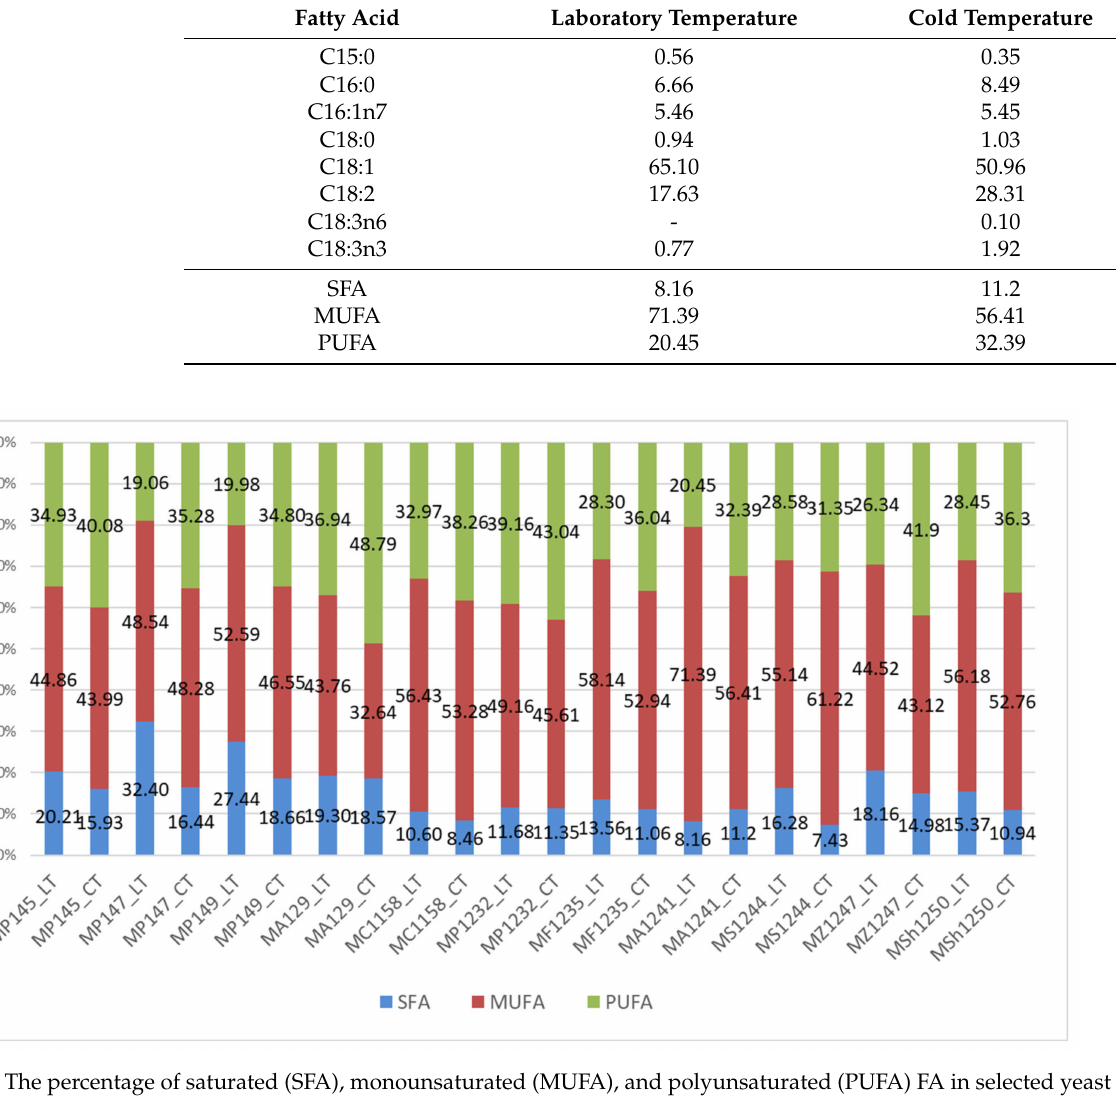
Figure 1. The percentage of saturated (SFA), monounsaturated (MUFA), and polyunsaturated (PUFA) FA in selected yeast strains grown at laboratory temperature (LT) and low cold temperature (CT). Legends: LT means 25 ◦ C, CT means 15 ◦ C, MP145— Metschnikowia pulcherrima 145, MP147— Metschnikowia pulcherrima 147, MP149— Metschnikowia pulcherrima 149, MA129— Metschnikowia andauensis 129, MC1158 – Metschnikowia chrysoperlae 1158, MP1232— Metschnikowia pulcherrima 1232, MF1235— Metschnikowia fructicola 1235, MA1241— Metschnikowia andauensis 1241, MS1244— Metschnikowia sinensis 1244 , MZ1247— Metschnikowia zizyphicola 1247, MSh1250— Metschnikowia shanxiensis